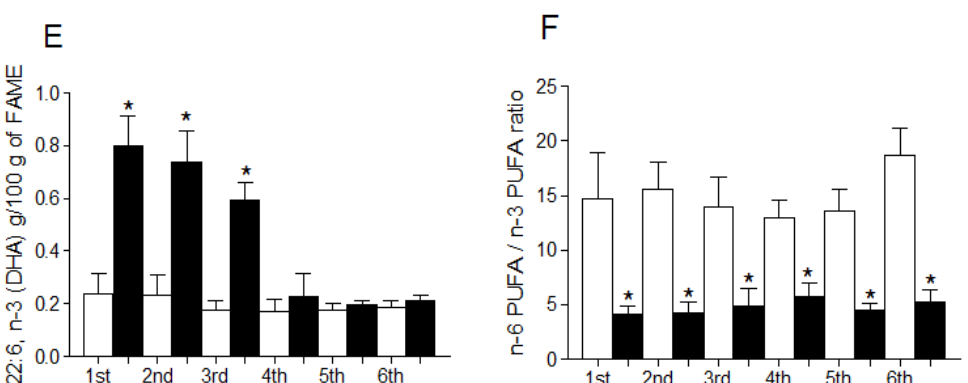
Figure 2. Individual fatty acid composition of breast milk from mothers during nursing.